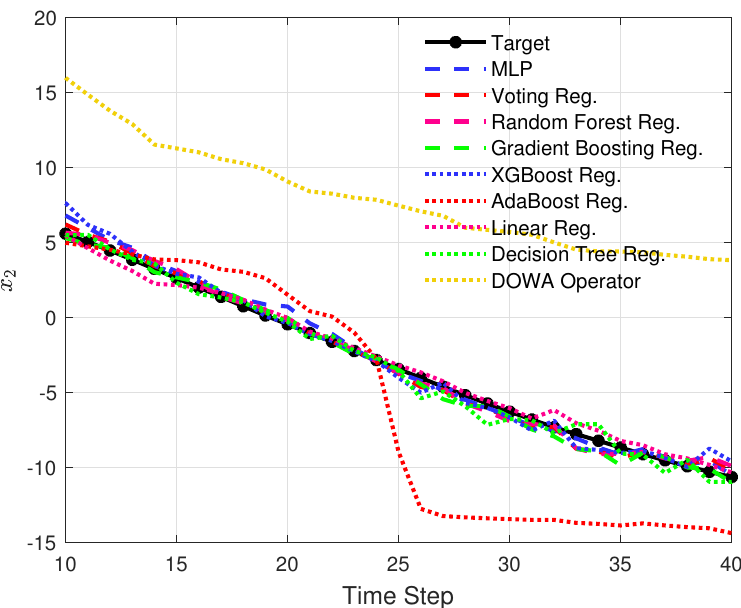
Figure 13. Fusion results for one Monte Carlo simulation for state 2 (zoomed